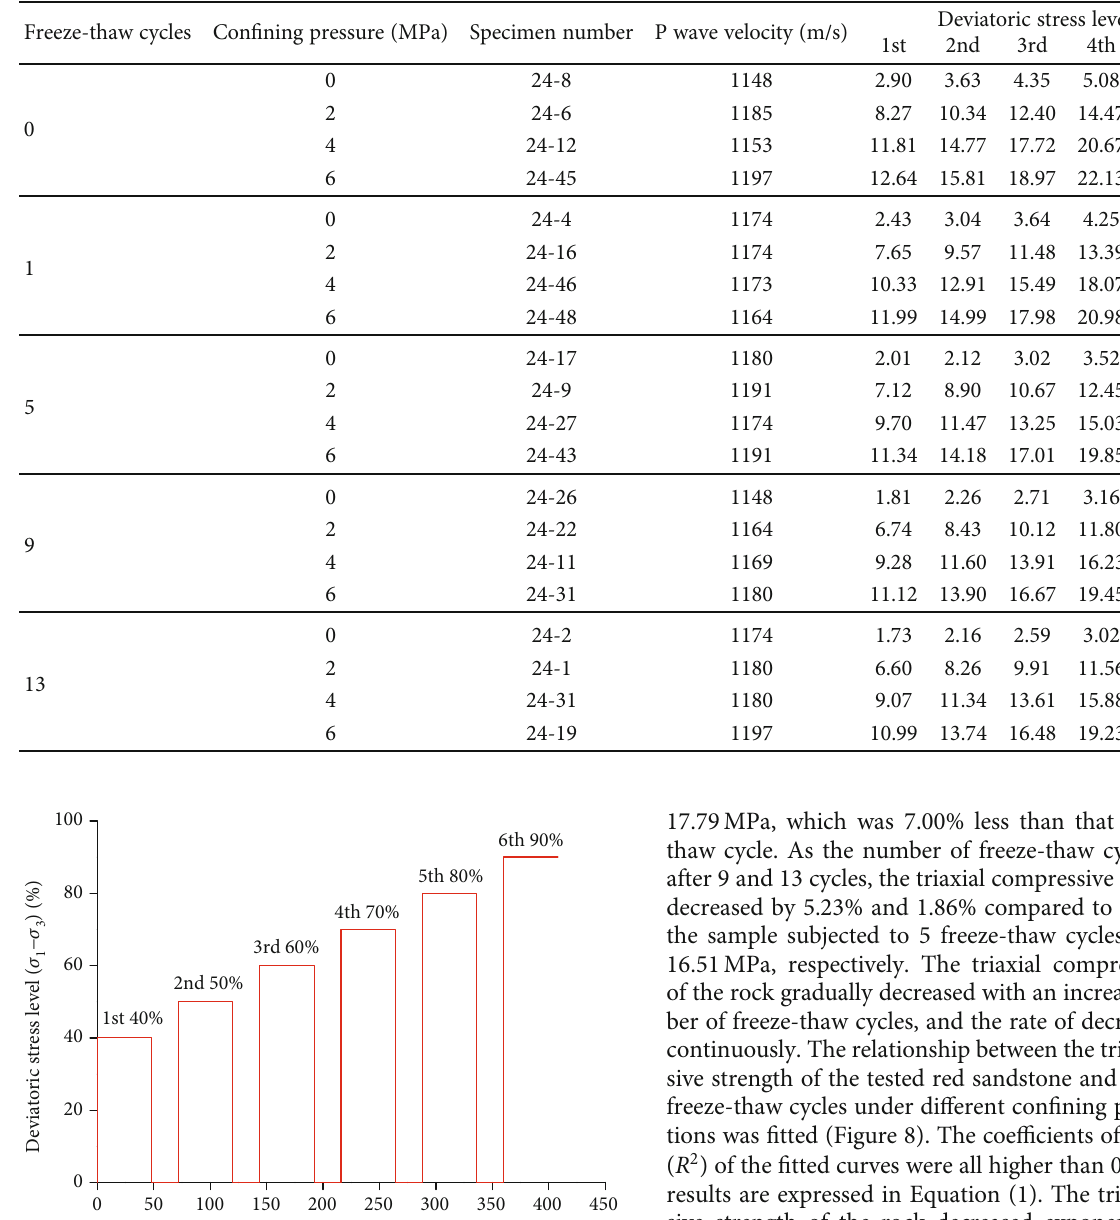
Table 3: Deviatoric stress levels the during triaxial creep tests of red sandstone after freeze-thaw.